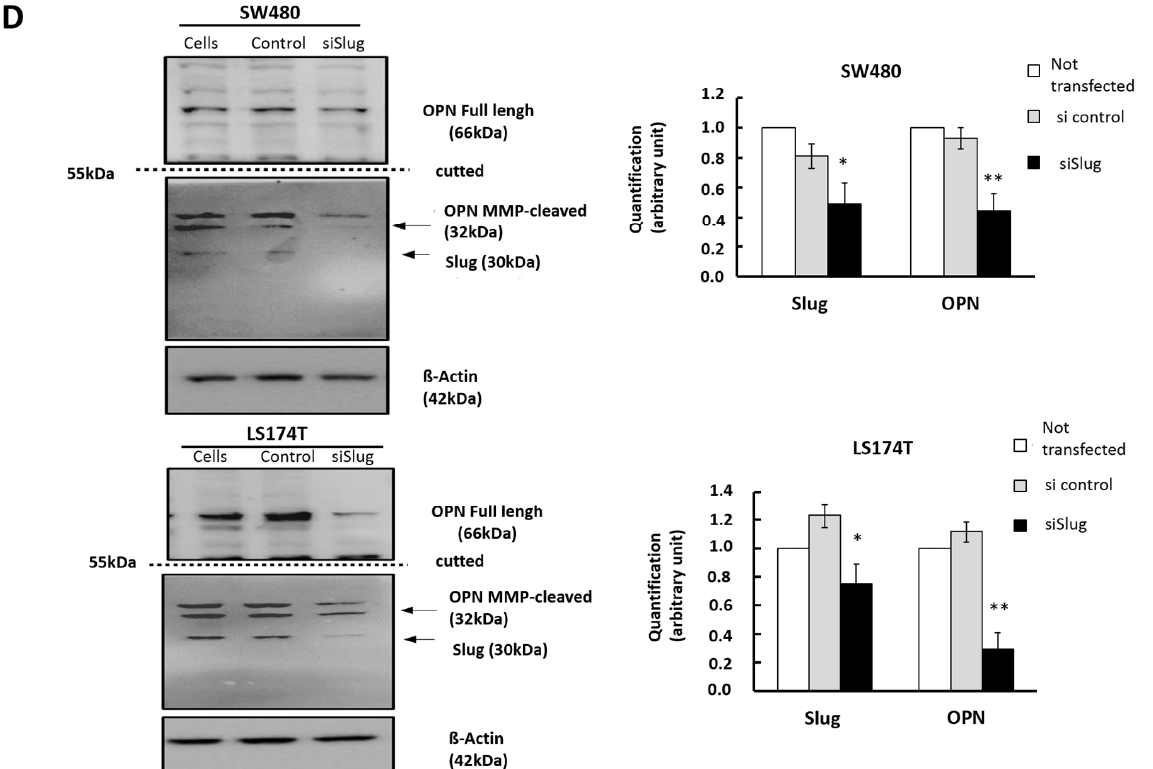
Figure 2. Influence of Slug/SNAI2 on OPN expression in CRC cells with different genetic back- ground. ( A ). Relative expression of OPN mRNA following transitory transfection of Slug as com-